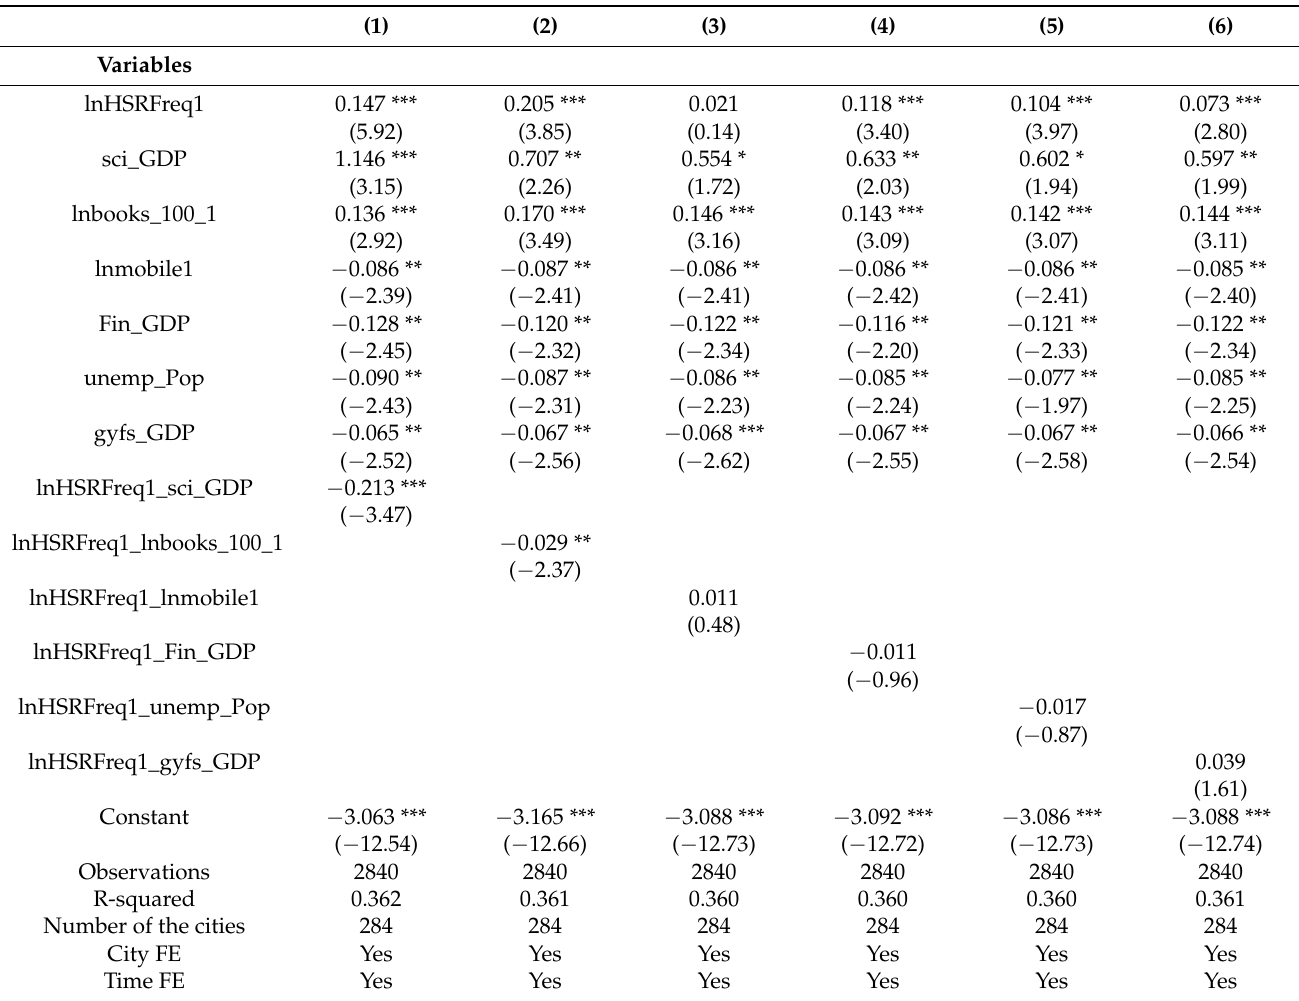
Table 6. The result of the further test of